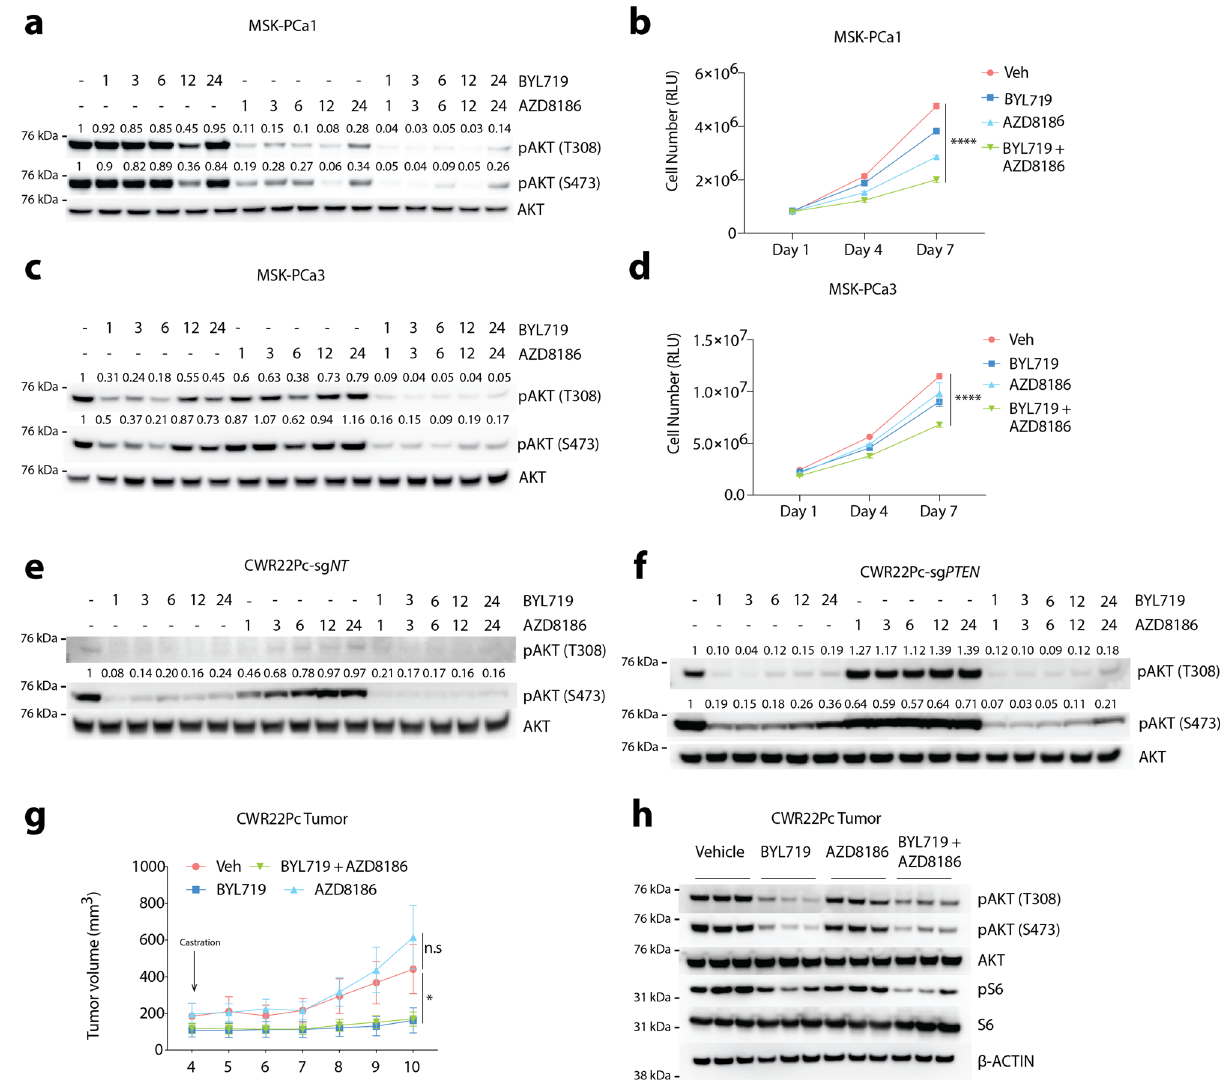
Fig. 3 PTEN-de fi ciency enhances relief of feedback inhibition through p110 α and p110 β signaling following contralateral isoform selective inhibition. a , c Western blot showing pAKT levels in PDO models MSK-PCa1 and MSK-PCa3 treated with BYL719 (1 µ M), AZD8186 (250 nM), BYL719 + AZD8186, or Veh for 0, 1, 3, 6, 12, and 24 h, respectively. Quanti fi cation of pAKT473 and pAKT308 normalized to total AKT. b , d Growth assay of PDO lines MSK-PCa1 and MSK-PCa3 treated with BYL719 (1 µ M), AZD8186 (250 nM), BYL719 + AZD8186, or Veh. Cell number was read using CellTiter-Glo assay on Day 1, Day 4, and Day 7, respectively. e , f Western blot showing pAKT levels in CWR22Pc-sg NT or CWR22Pc-sg PTEN isogenic pairs treated with BYL719 (1 µ M), AZD8186 (250 nM), BYL719 + AZD8186, or Veh for 0, 1, 3, 6, 12, and 24 h, respectively. Quanti fi cation of pAKT473 and pAKT308 normalized to total castrated when tumor reaches ~200 mm 3 . h Western blot showing pAKT and pS6 levels in CWR22Pc tumors from ( g ). Source data are provided as Source data fi le. All assays were performed with three biological replicates. **** p < 0.0001, * p = 0.0142, n.s: not signi fi cant, b , d , g : one-way ANOVA compared to Veh group, error bar represents mean values ± SD, g : error bar represents mean values±